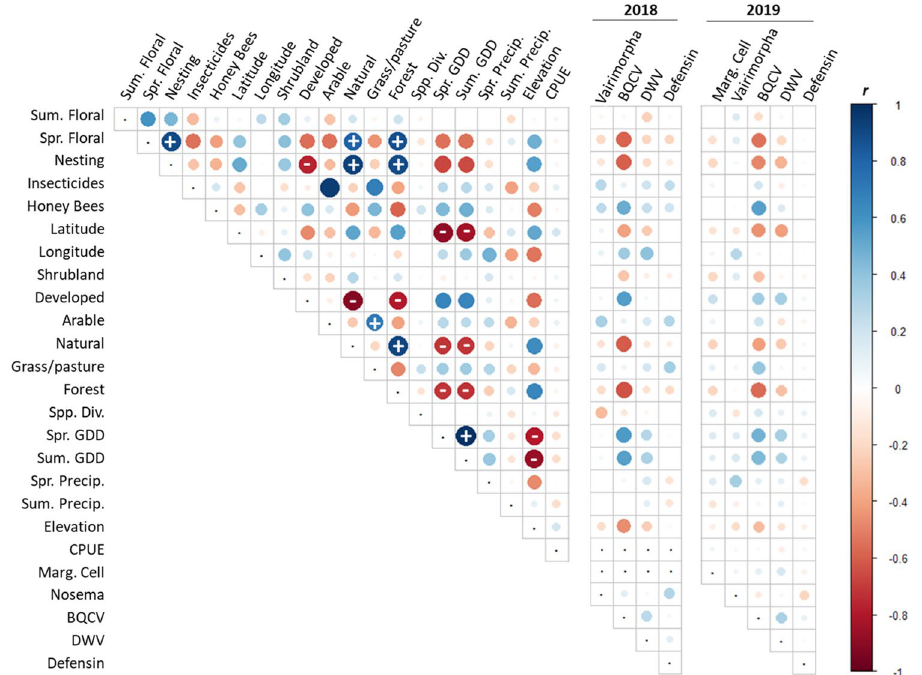
Figure 4. Correlation matrix for all pairwise independent- (2019 shown) and response variables in 2018 (center) and 2019 (right) for Bombus impatiens workers from 38 counties in Pennsylvania. Values within each cell represent Pearson’s Correlation Coefficient ( r ). Circle size indicates the magnitude of r with values ≥ 0.70 denoted with a sign overlaying each circle. Habitat variables shown include summer floral (“Sum. Floral”), spring floral (“Spr. Floral”), nesting resources (“Nesting”), insecticide loading (“Insecticides”), honey bee ( Apis mellifera ) colony density (“Honey Bees”), latitude, longitude, percent shrubland (within 500 m; “Shrubland”), percent urban development (“Developed”), percent arable (“Arable”), percent natural (“Natural”), percent grassland/pasture (“Grass/pasture”), percent forest (“Forest”), and elevation. Additionally shown are weather variables: spring growing degree days (“Spr. GDD”), summer growing degree days (“Sum. GDD”), amount of spring precipitation (“Spr. Precip.”), and amount of summer precipitation (“Sum. Precip.”). Finally, we also included Bombus spp. standardized Shannon diversity (H ′ ; “Spp. Div.”) and number of B. impatiens captures per hour/observer (“CPUE”). Response variables included forewing marginal cell size (“Marg. Cell”), Vairimorpha infection, black queen cell virus infection (“BQCV”), deformed wing virus infection (“DWV”), and Defensin